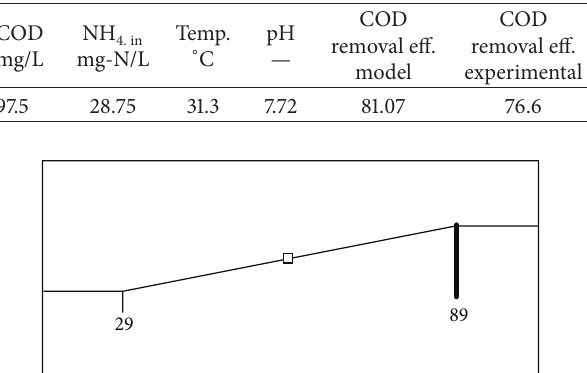
Table 8: The optimum conditions.